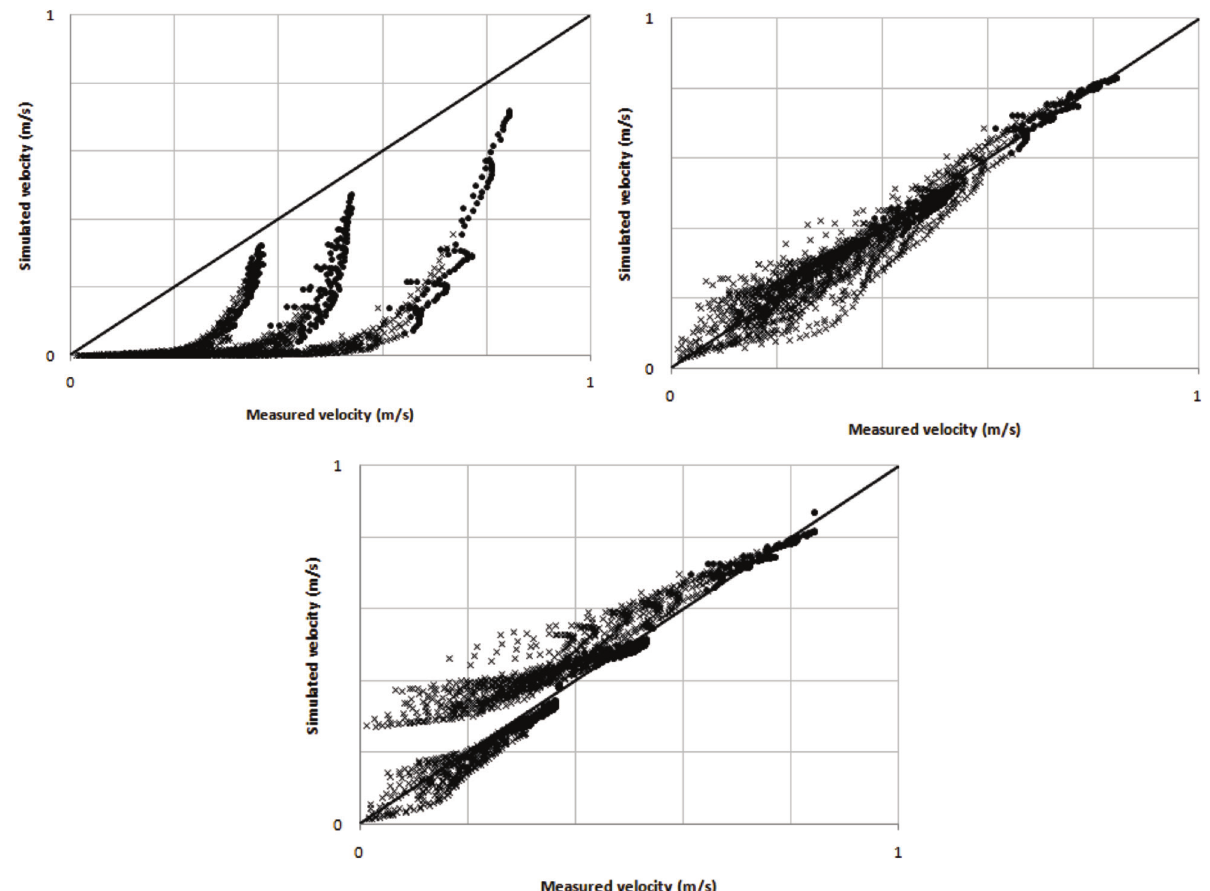
Figure 3. Correlation between measured (experiments SRP1, SRP2, and SRP3: Steffler et al ., 1985) and simulated velocities using the strong statement (curvilinear coordinates): (a) model U1ξ; (b) model U2ξ; and (c) model U3ξ. The black dots represent points located further than 3% of the channel width from the sidewalls and from the channel bed, whereas the plus (+) signs refer to the points located elsewhere (near wall and/or channel